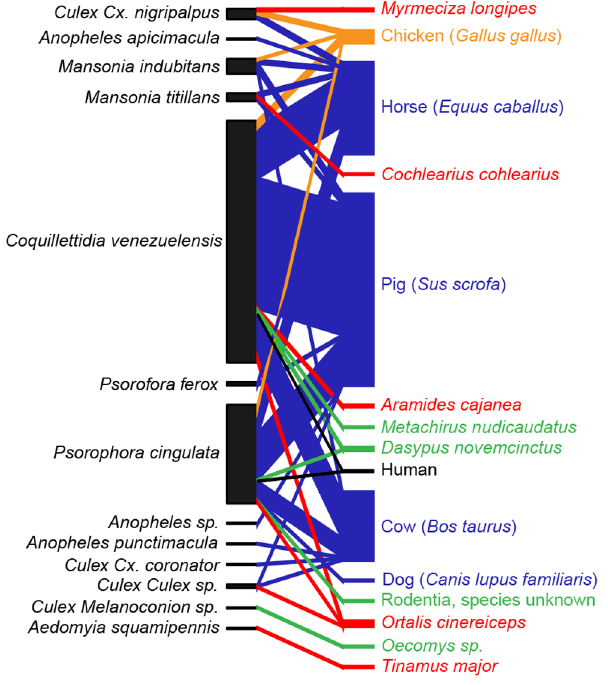
Figure 2. Host-vector quantitative interaction network based on the molecular identification of 338 mosquito blood meals from Aruza Abajo, Panama. Red lines represent interactions involving wild birds, green lines: wild mammals, orange lines: chickens, blue lines: domestic mammals, and black lines: humans.